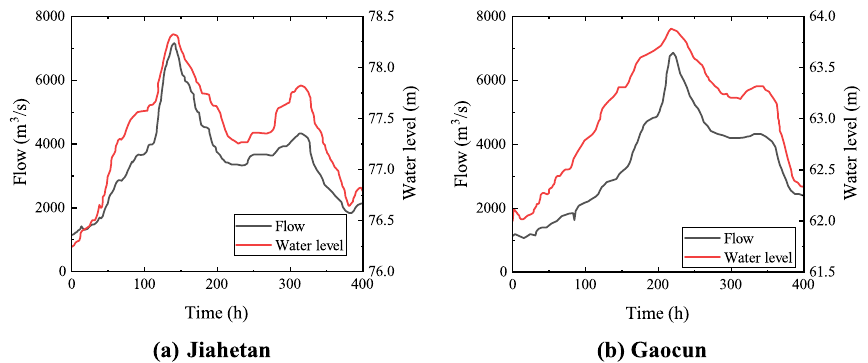
Fig. 4 “96.8” flood process. a Jiahetan. b Gaocun